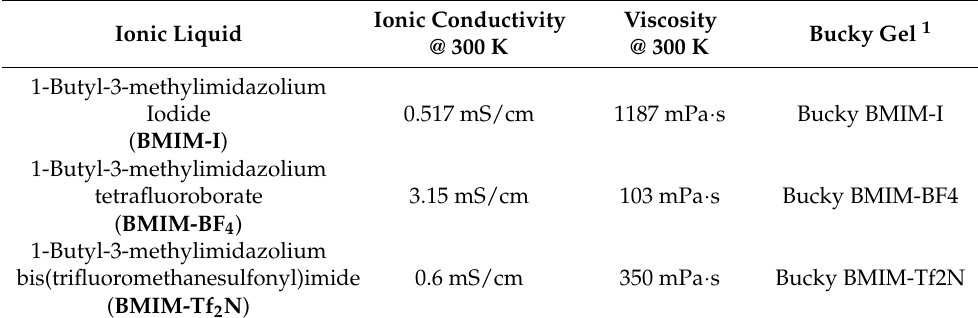
Table 1. List of the 3 types of adopted room temperature ionic liquids used for the realization of the CNT bucky